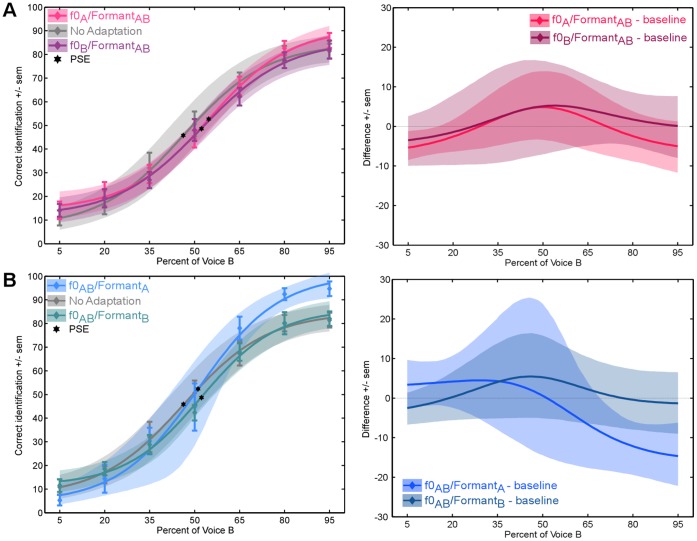
Adaptation to formant and fundamental frequencies.(A) Aftereffects induced with the fundamental frequency adaptor (f0A/formantAB). Right panel: statistical analysis, differences between each adaptation condition and baseline (i.e., no adaptation). Shaded area: 95% confidence interval. (B) Aftereffects induced with the formant adaptor (f0AB/formantA). Right panel: statistical analysis, differences between each adaptation condition and baseline (i.e., no adaptation). Shaded area: 95% confidence interval.